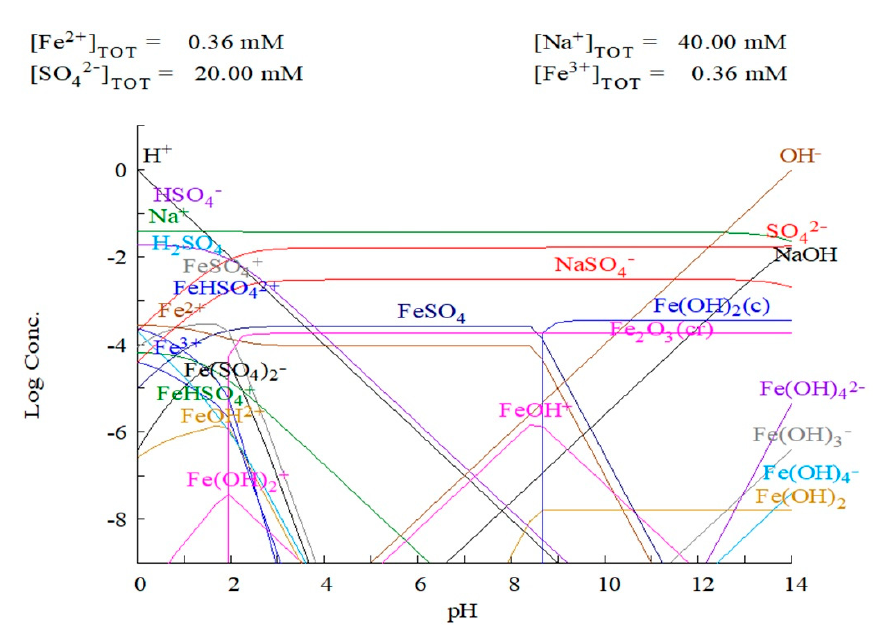
Figure 8. Chemical speciation diagram for iron, generated from Hydra-Medusa software.